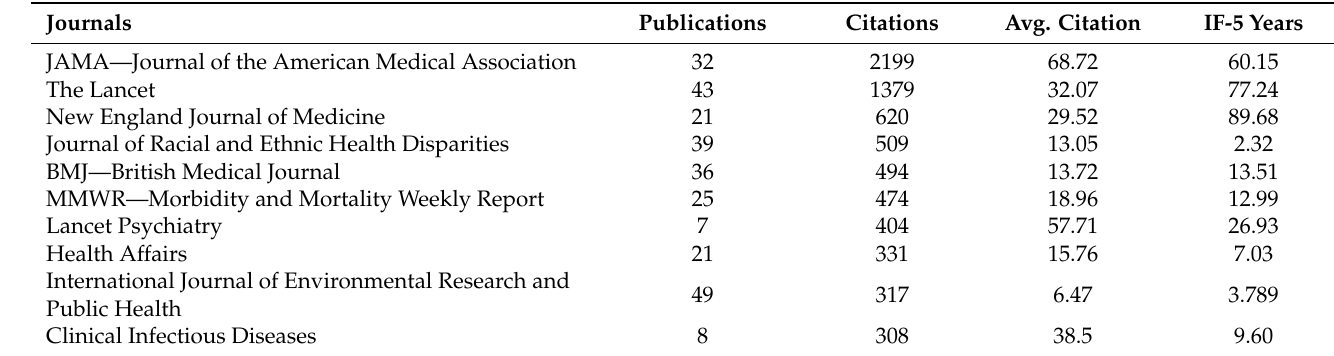
Table 5. Top 10 journals with high citation